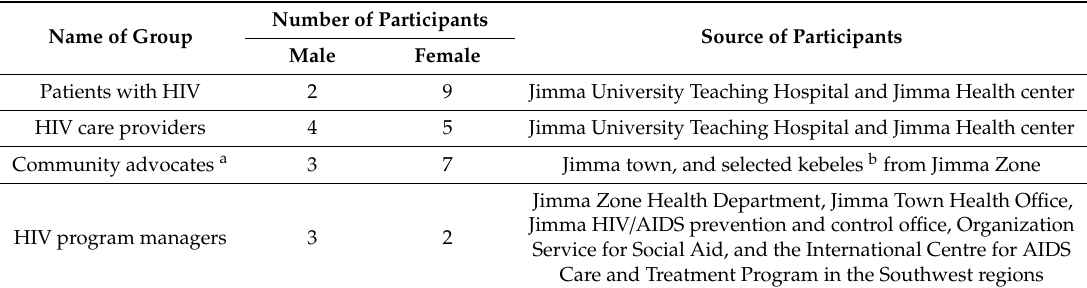
Table 1. Sample size and study participants, Jimma, Southwest Ethiopia, 2017 /